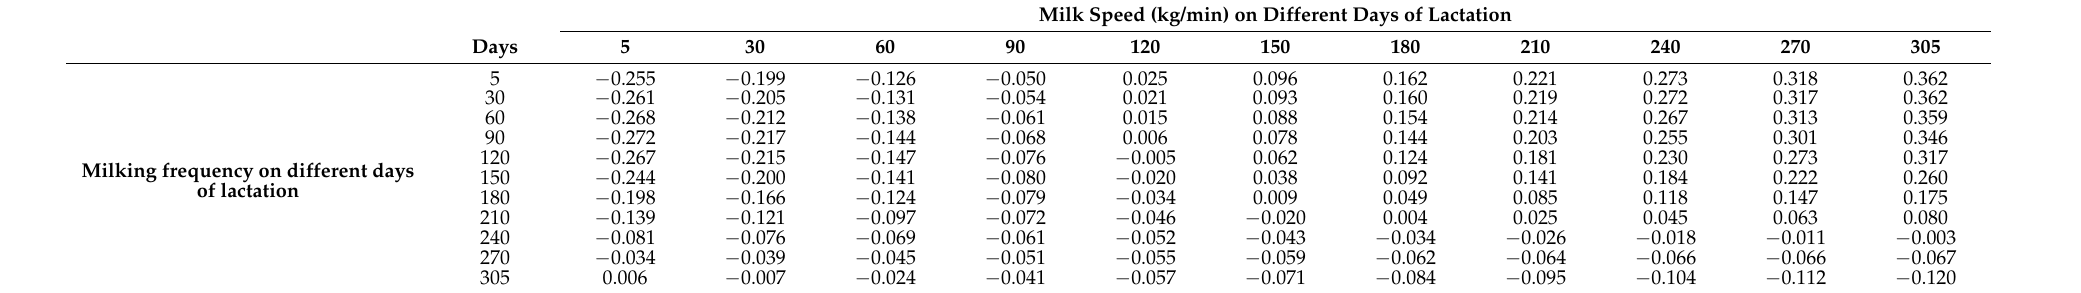
Table 8. Genetic correlations between milking frequency and milk speed in different days of lactation.